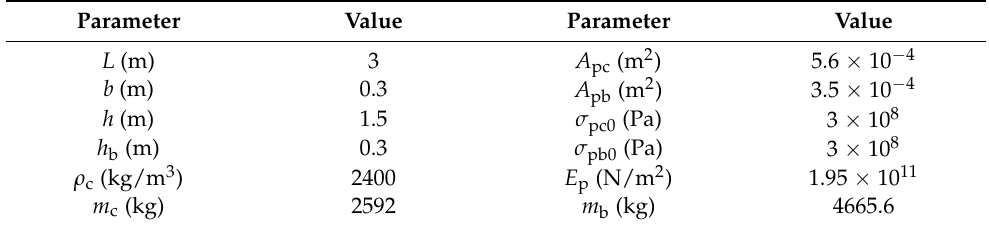
Table 1. Parameters of the basic model.